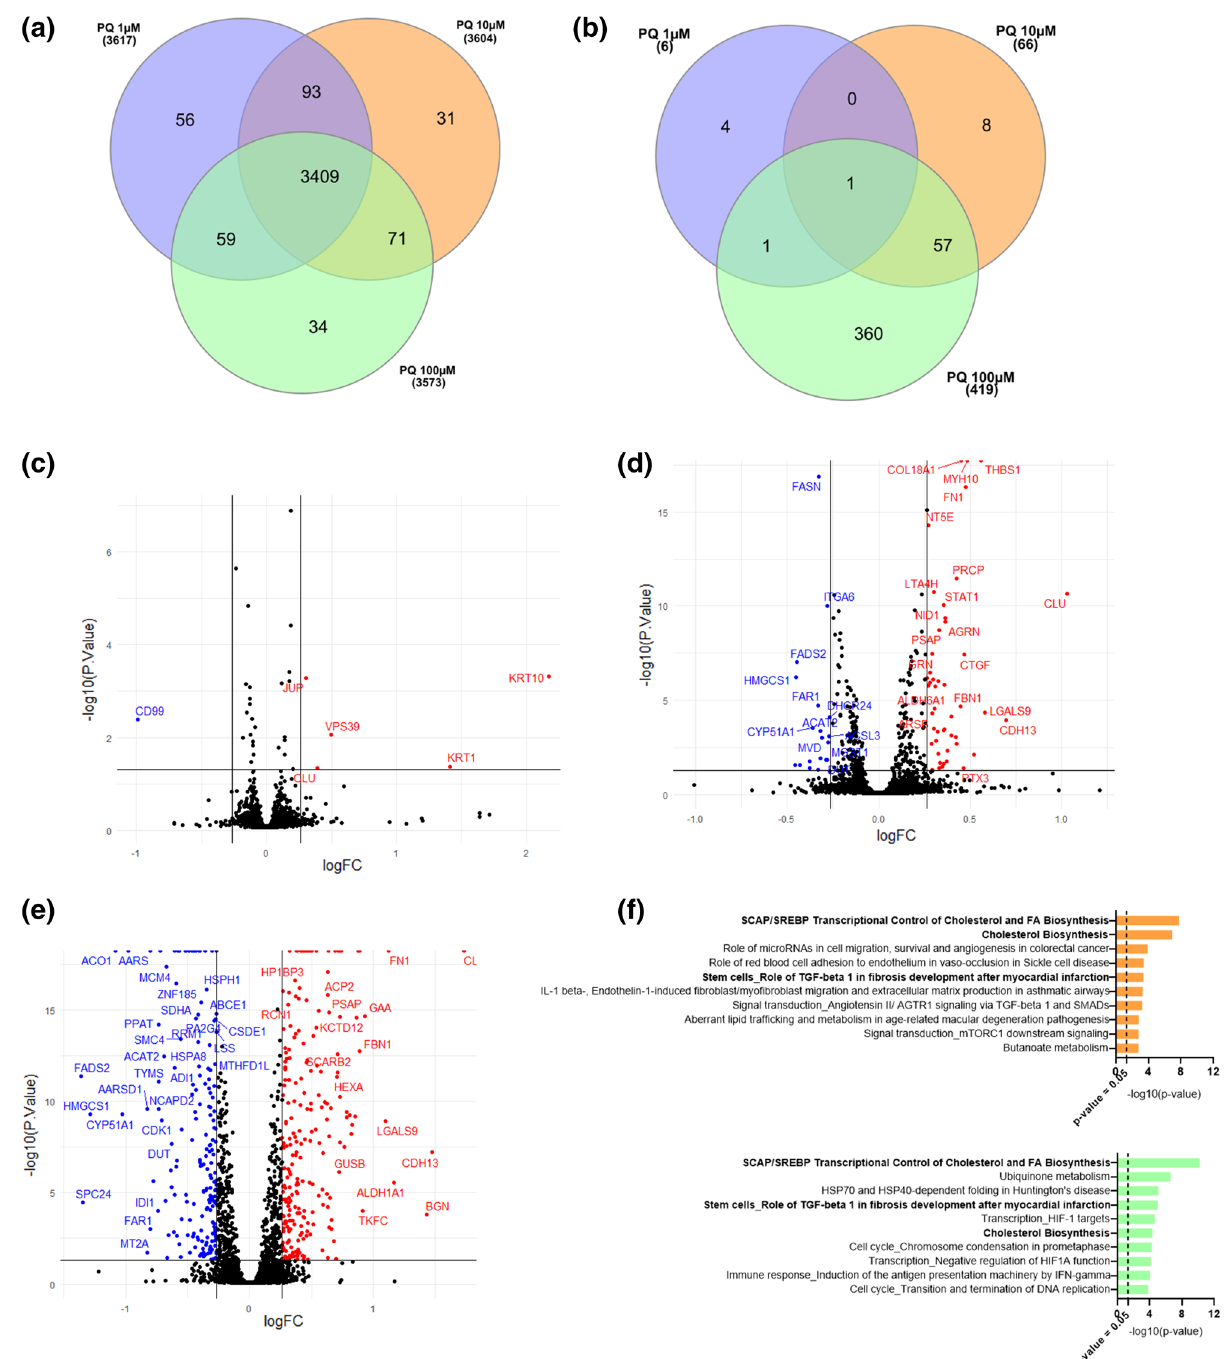
Figure 1. ( a – f ) Proteomics data and enrichment pathway results of PQ-treated HBMECs at 1 µM, 10 µM and 100 µM for 24 h. ( a ) Venn diagram displaying a comparison of total quantified proteins in HBMECs after PQ concentrations at 1, 10 and 100 µM. ( b ) Venn diagram displaying a comparison of total DEPs in HBMECs after PQ concentrations at 1, 10 and 100 µM. ( c – e ) Volcano plots displaying the distribution of all proteins after PQ concentrations at 1 µM ( c ), 10 µM ( d ) and 100 µM ( e ) in HBMECs. Downregulated proteins are in blue. Upregulated proteins are in red. X axis corresponds to log 2 (FC), Y axis corresponds to − log 10 ( p -value). ( f ) Top ten of pathway maps enriched by MetaCore software from the lists of DEPs (FC > 1.2, p -value ≤ 0.05, N = 3) after PQ concentrations at 1 µM (purple), 10 µM (orange) and 100 µM (green) for 24 h. The top 10 pathways for each condition are represented in the graph. X axis corresponds to − log 10 ( p -value), Y axis corresponds to the name of biological pathways and the dashed line represents the enrichment p -value cut-off of